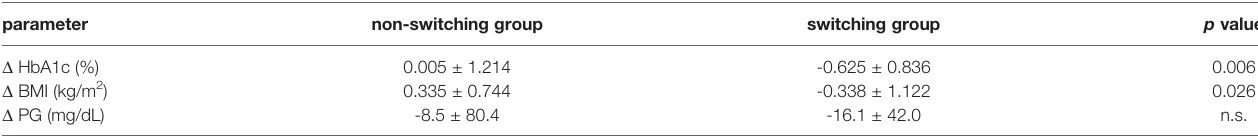
TABLE 4 | Comparison of the changes of various parameters for 6 months between non-switching group and switching group. Study 2.